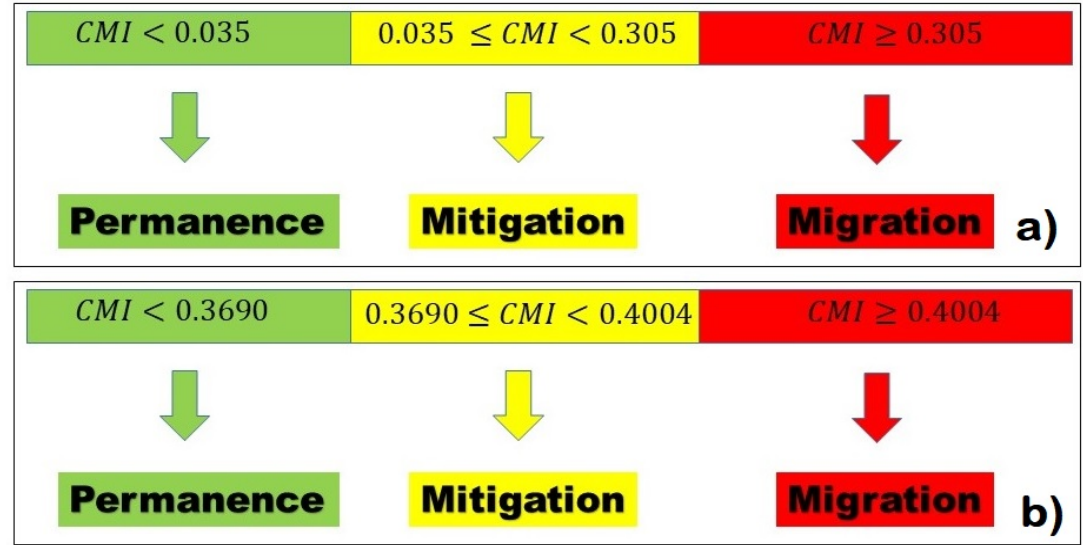
Figure 7. Interpretation ranges for CMI values associated with a stoplight. Caption: ( a ) Mexico case and ( b ) Cuba case .